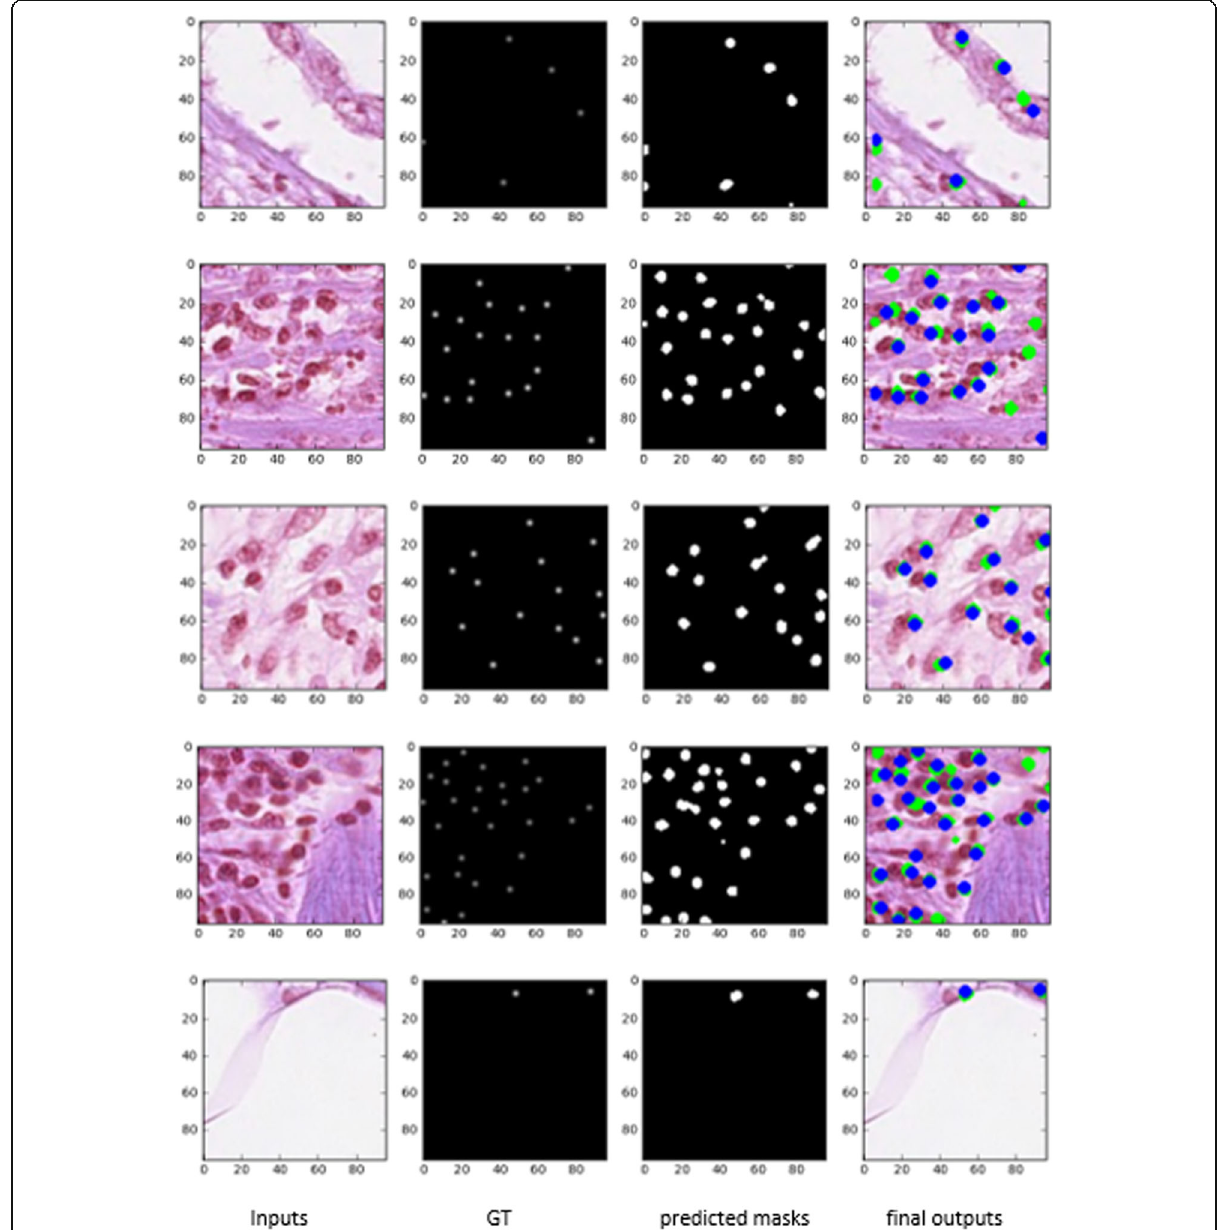
Fig. 15 Nuclei detection outputs with inputs, ground truth, model outputs after thresholding, and final outputs with a blue and green dot. The blue dot represents the ground truth and the green dot shows the center pixels of the network